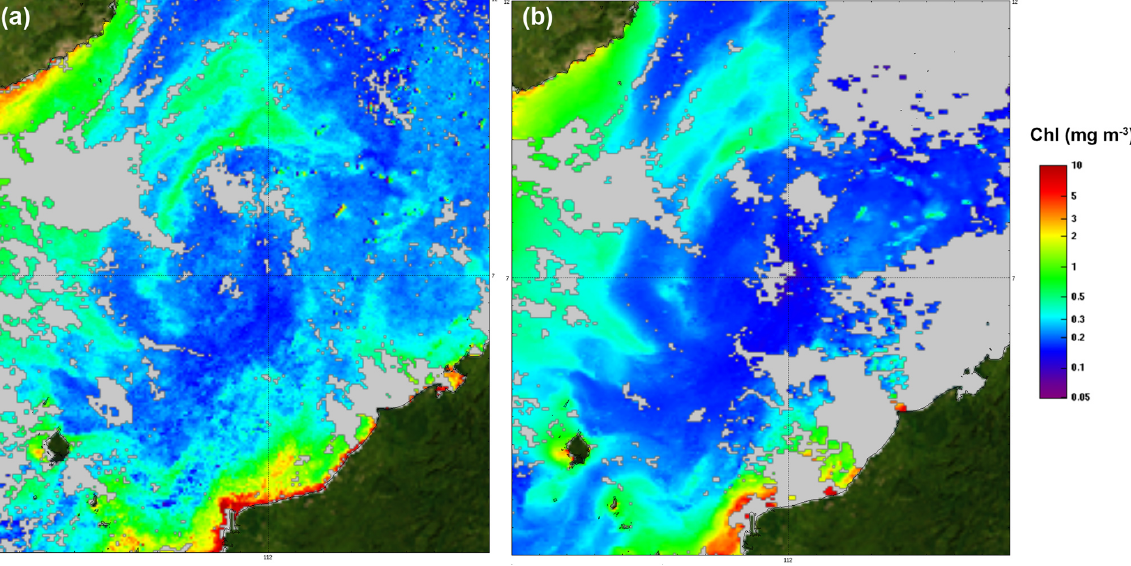
Ocean Sci., 15, 819–830, 2019